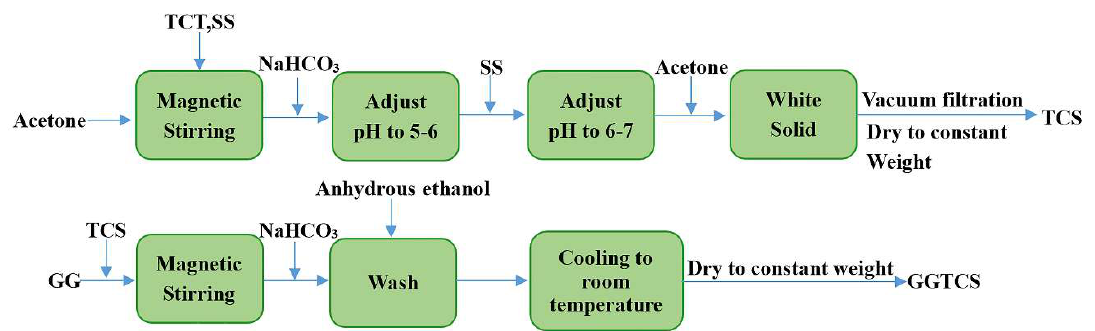
Figure 3. GGTCS synthesis flow chart (modified guar gum (GG) with cyanuric chloride (TCT) and sodium sulfamate (SS) forms the modified product GGTCS) [35].